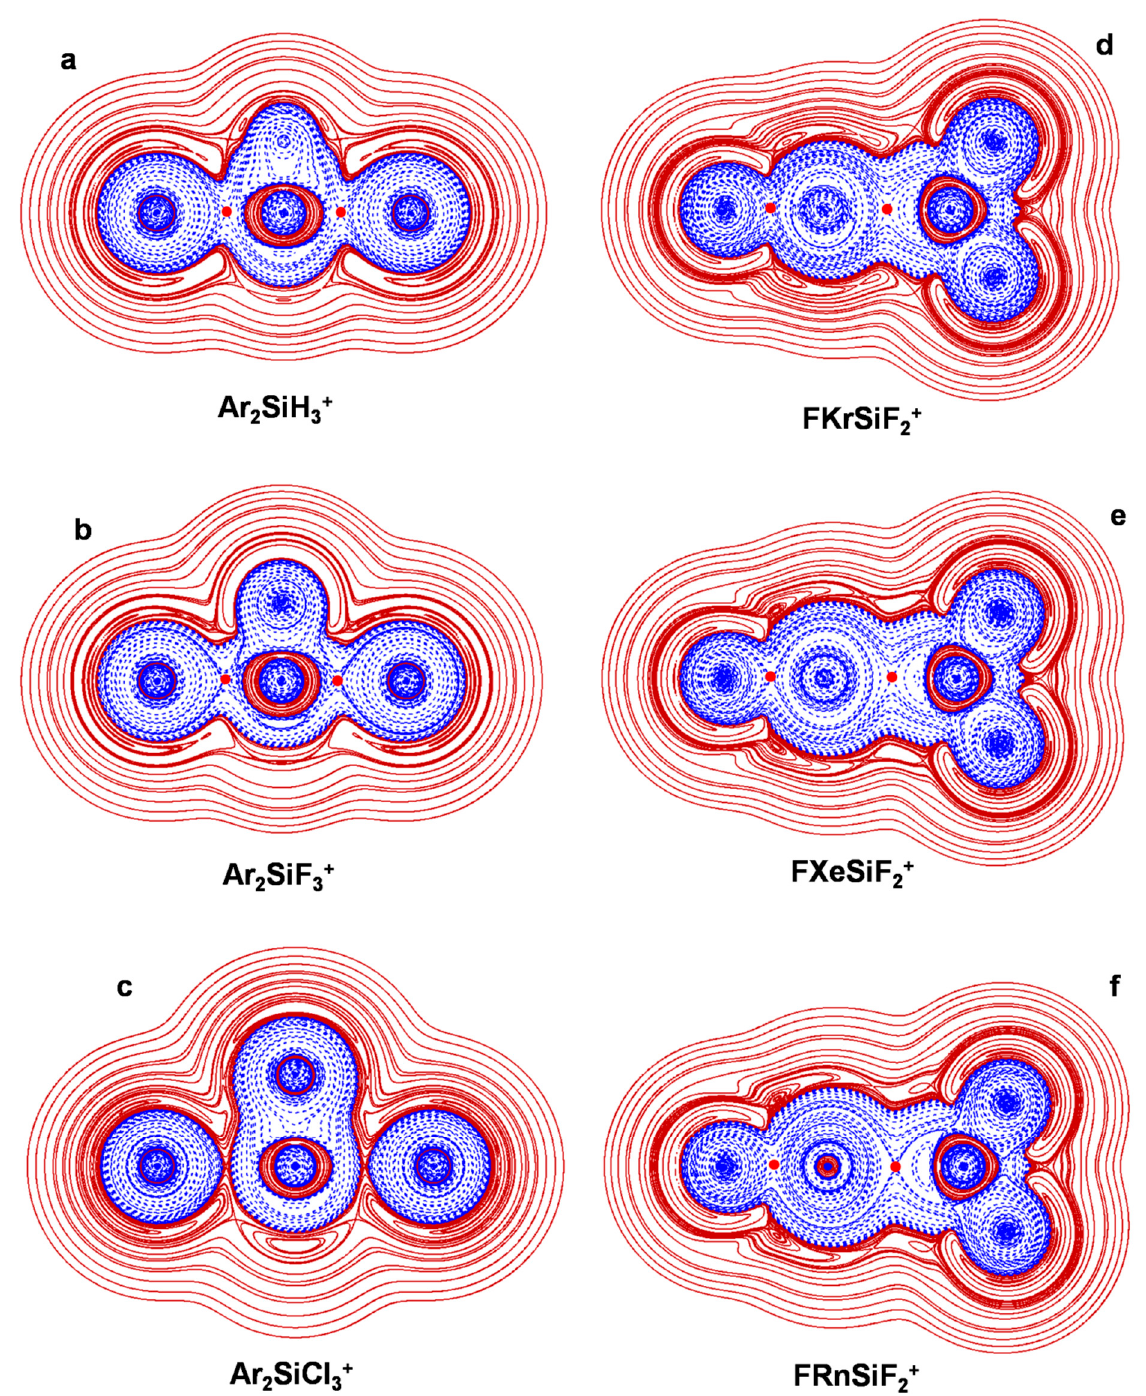
Figure 5. 2D plots of H ( r ) in the symmetry plane of ( a ) Ar 2 SiH 3+ ; ( b ) Ar 2 SiF 3+ ; ( c ) Ar 2 SiCl 3+ ; ( d ) FKrSiF 2+ ; ( e ) FXeSiF 2+ ; ( f ) FRnSiF 2+ (solid/brown and dashed/blue lines correspond, respectively, to positive and negative values). The red dots represent the HCPs.